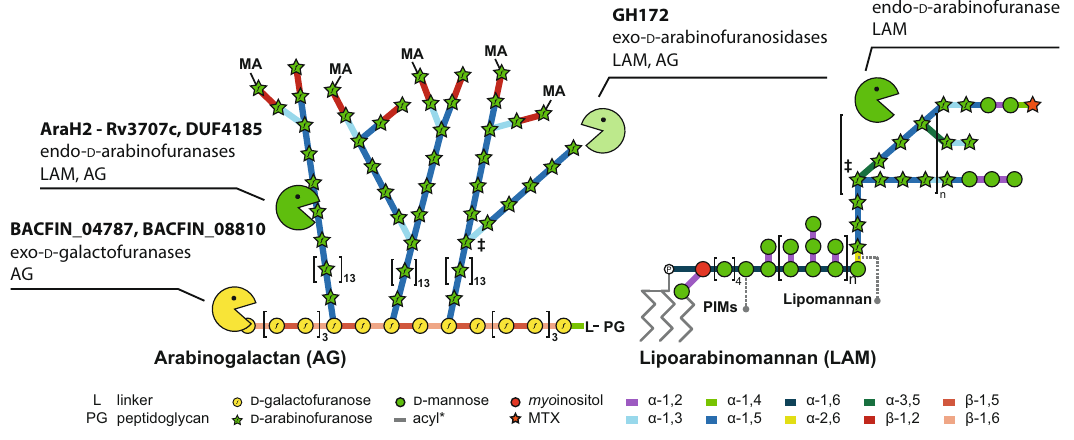
Fig. 6 | Mycobacterial arabinogalactan-degrading enzymes discovered in this study and their substrates. Each enzyme or enzyme family is listed with its identi fi ed function and the mycobacterial cell wall component it acts upon.